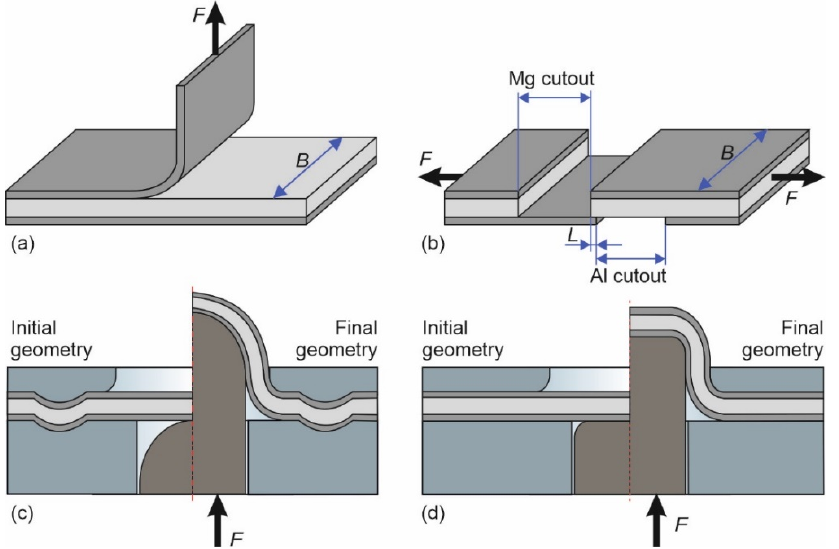
Figure 2. Compound characterization methods. ( a ) Peel test; ( b ) Lap shear test; ( c ) Nakajima test; ( d ) Deep drawing test.